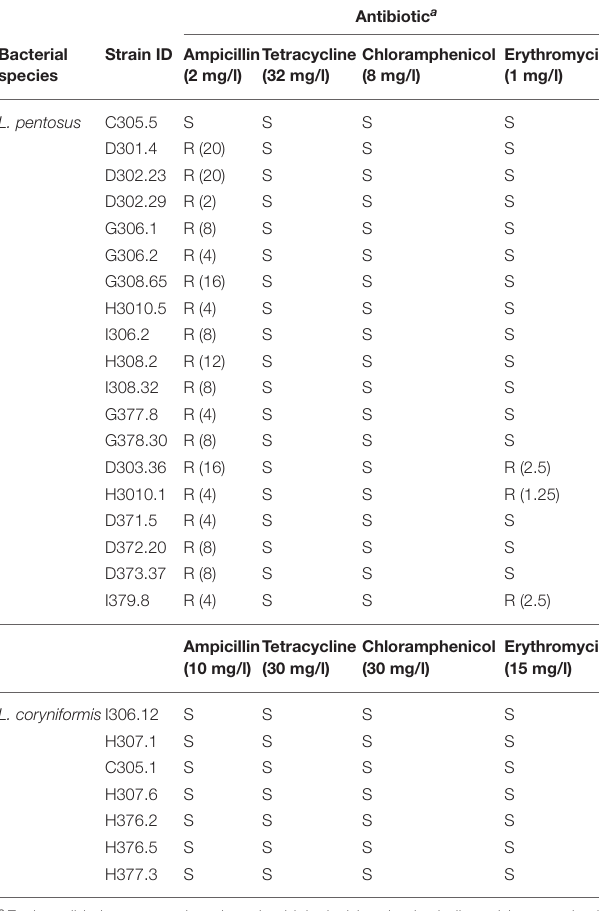
TABLE 3 | Antibiotic resistance of L. pentosus and L. coryniformis strains. TABLE 4 | Antimicrobial activity of L. pentosus and L. coryniformis strains against indicator